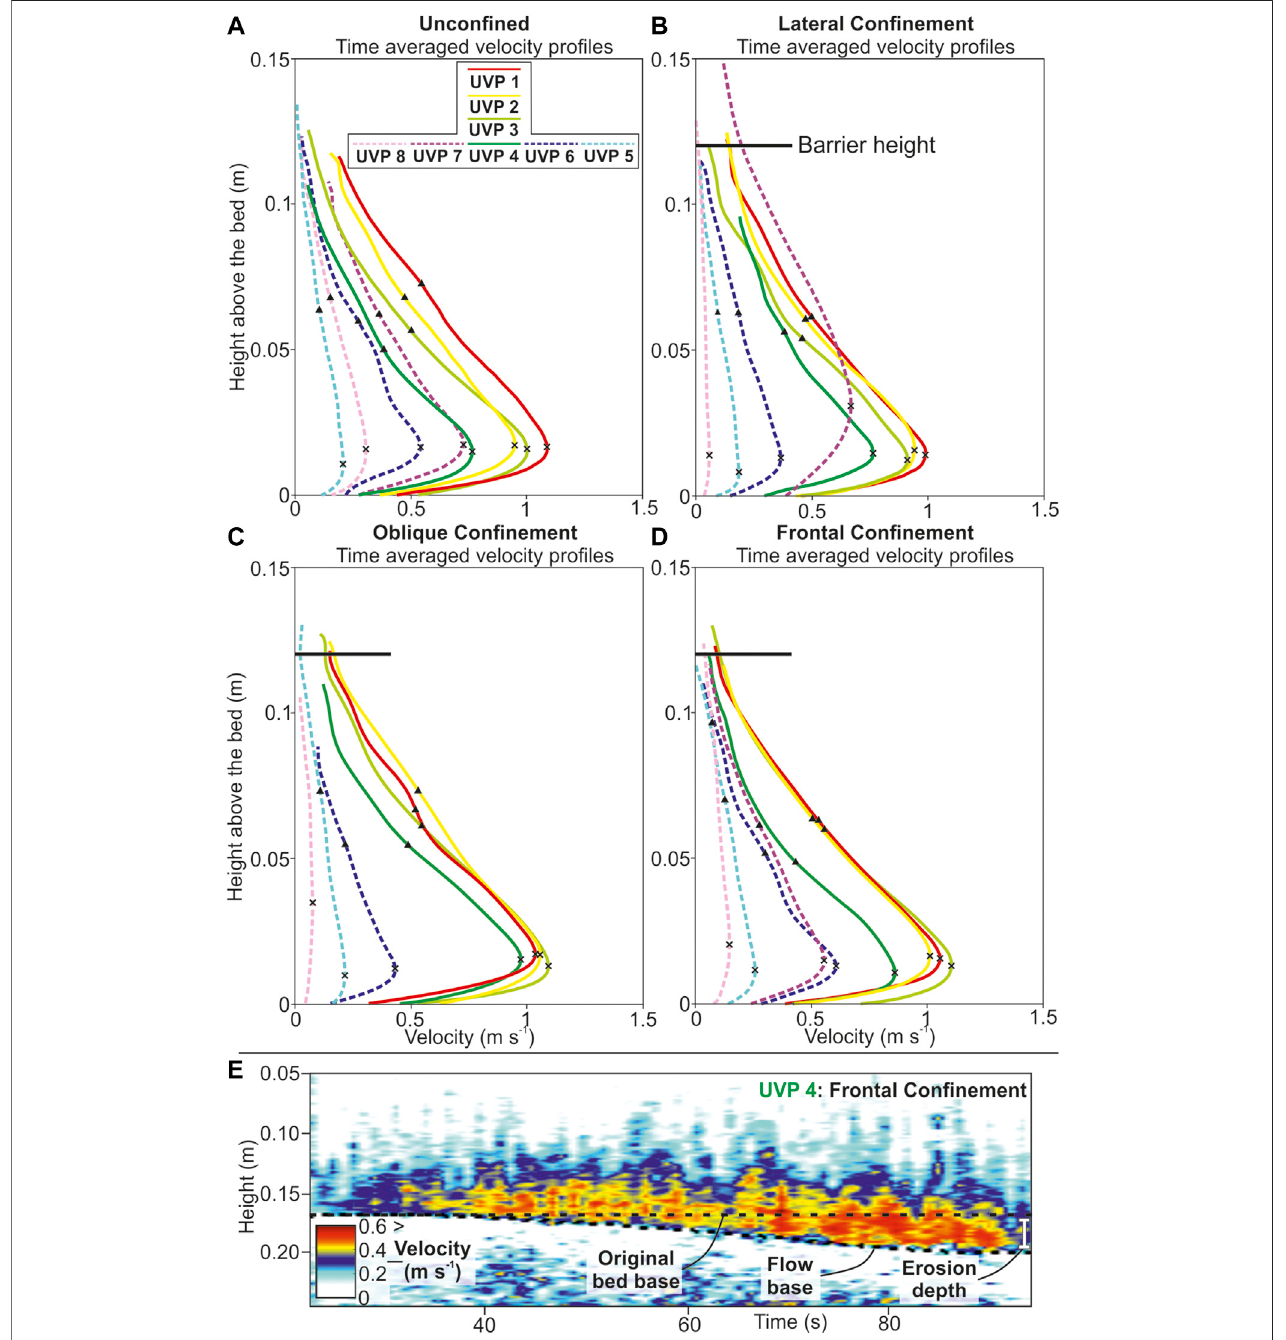
FIGURE 5 | (A – D) Time-averaged velocity pro fi les for each experimental run. Dashed lines indicate lateral velocity measurements. The head ( fi rst 5 s) and tail ( fi nal 15 s) have been cropped to exclude noise from the depth averaging process. The cross on the time-averaged velocity pro fi les is the U max , and the triangle is the fl ow height. (E) Velocity fi eld through the passage of frontally con fi ned turbidity current immediately downstream of the barrier. Acceleration through time and erosion is indicated by the UVP data.